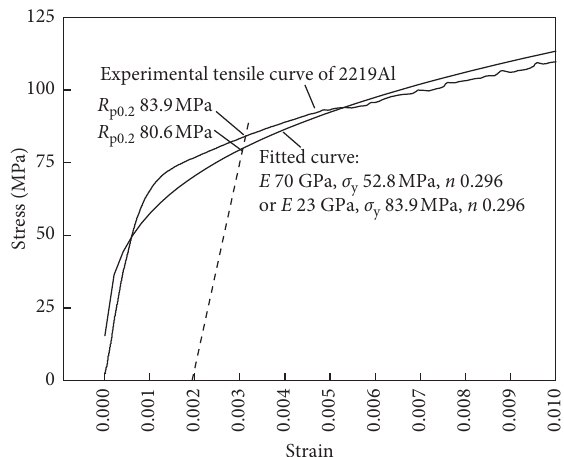
Fitted curve: E 70 GPa, σ y 52.8MPa, n 0.296